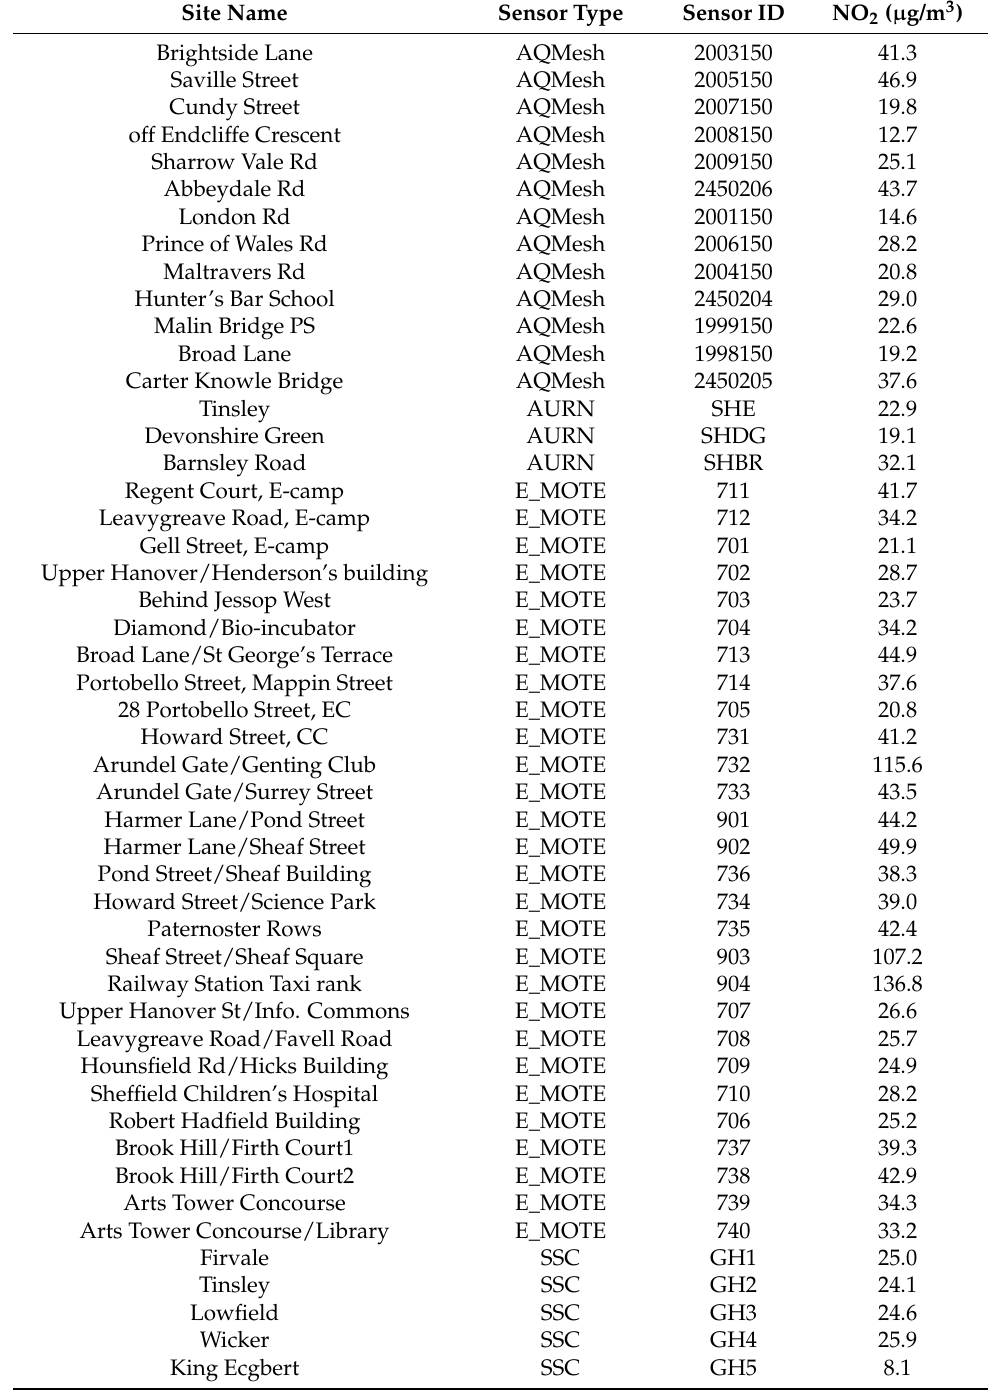
Table 1. Names, IDs and annual mean NO 2 concentrations ( µ g/m 3 ) measured by low-cost sensors (AQMesh and Envirowatch E-MOTEs) and AURN and Sheffield City Council sites from August